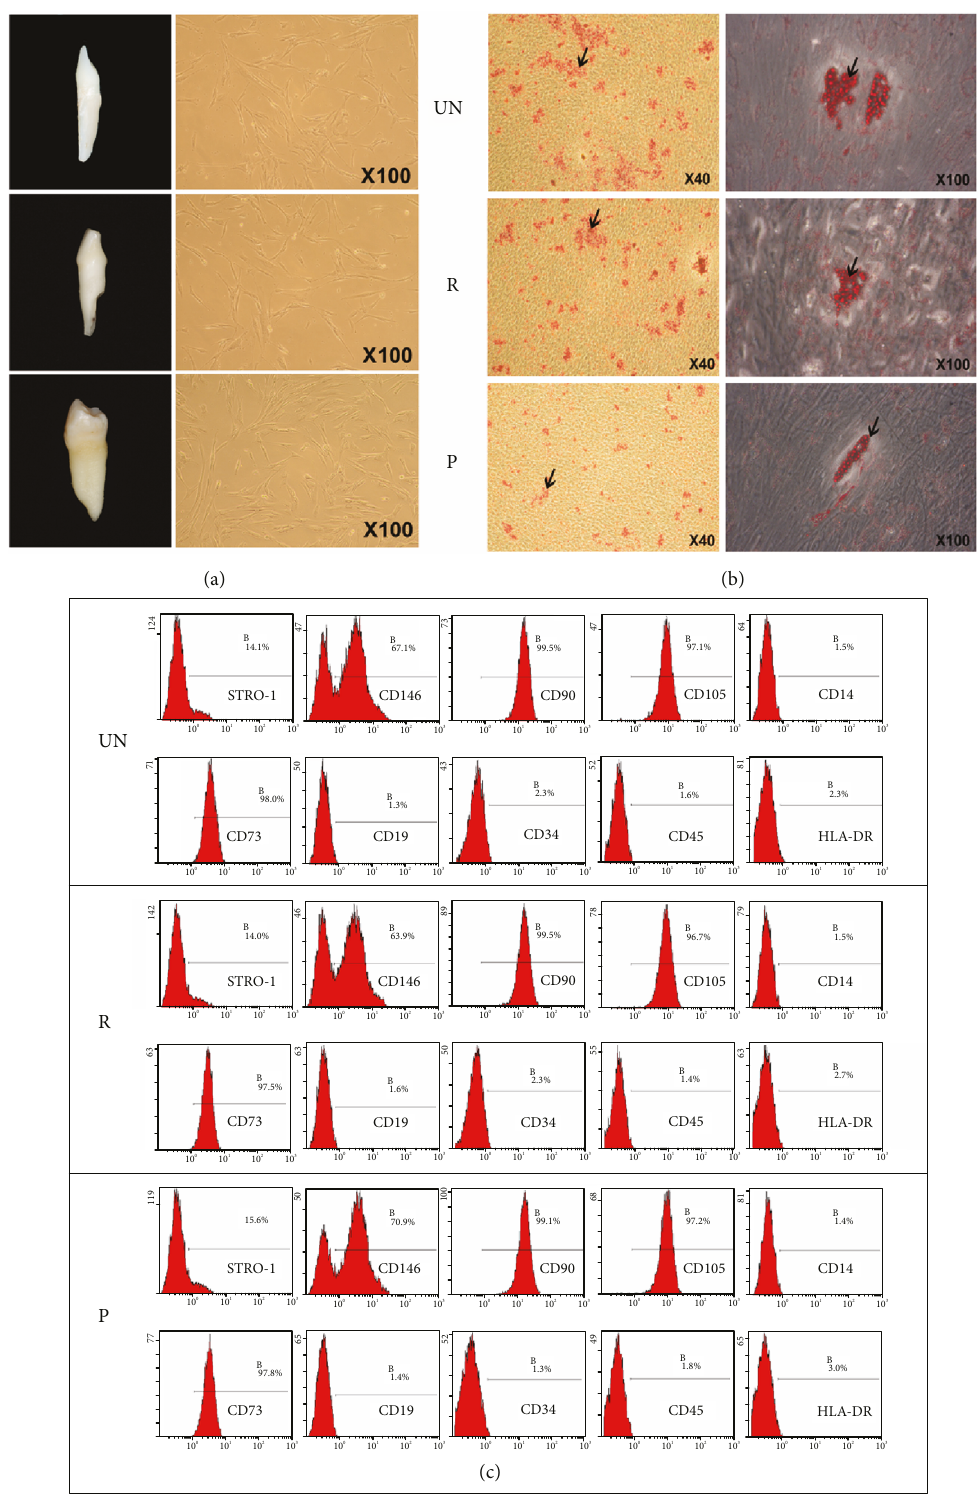
Figure 1: Isolation, culturing, and identi fi cation of PDLSCs. (a) Deciduous incisors and permanent premolars subdivided into three groups (UN, R, and P) showing the morphologies of the human-derived PDLSCs typical of fi broblast-like cells. (b) Cultured PDLSCs showing the mineralized nodules (alizarin red staining) following 21 days of osteogenic induction and lipid clusters (Oil red O staining) following 28 days of adipogenic induction. (c) Flow cytometry analysis of cultured PDLSCs from all groups revealed positive staining for STRO-1, CD146, CD90, CD105, and CD73 and a lack of staining for CD14, CD19, CD34, CD45, and